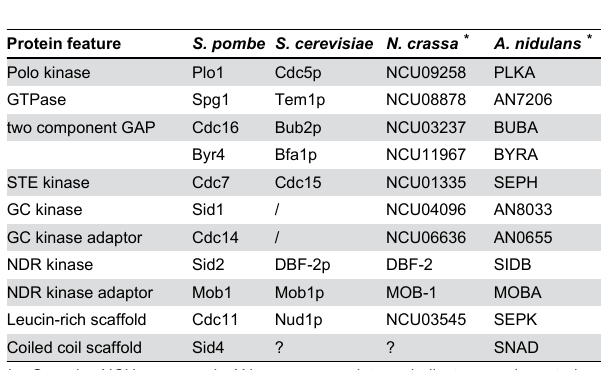
Table 1. (Predicted) SIN components in yeasts and filamentous